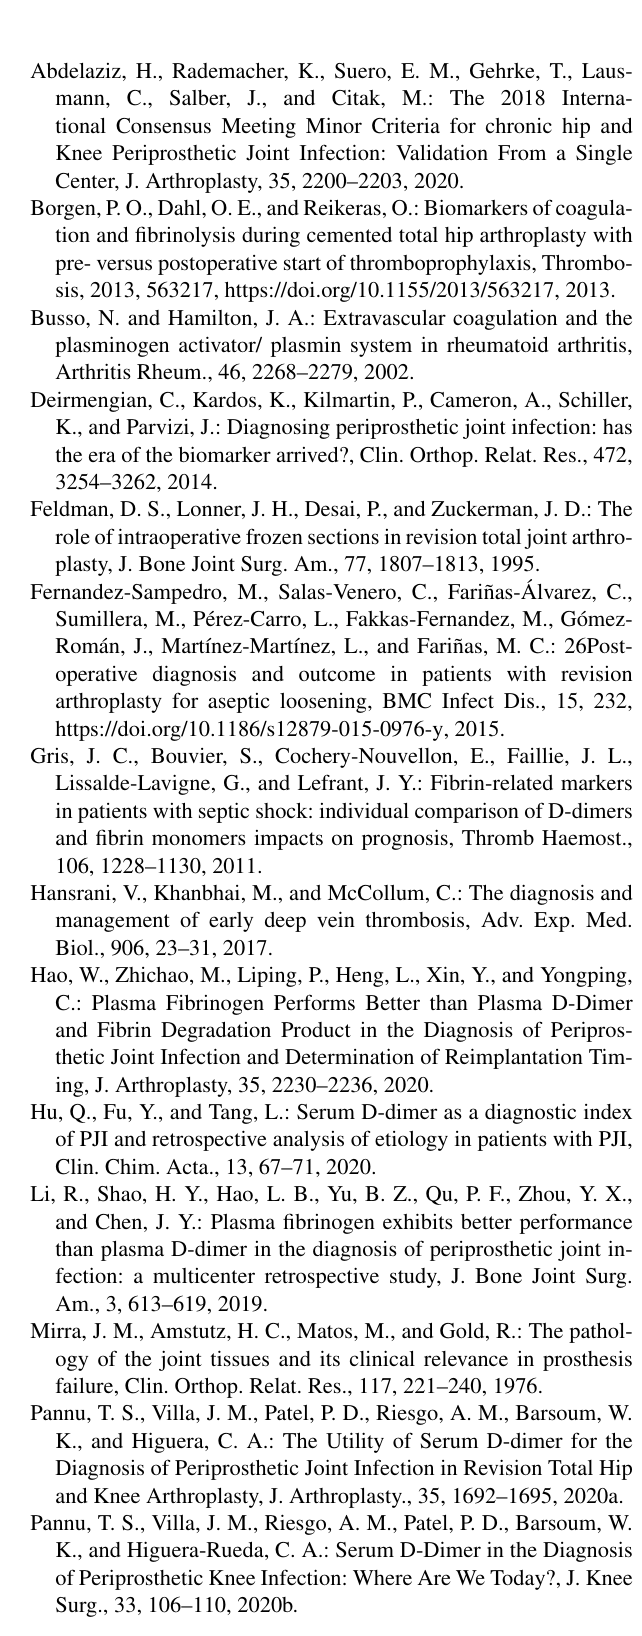
Table A2. Positive (PPV) and negative predictive value (NPV) of prosthetic joint infection for all cutoff points studied of D-dimer, C-reactive protein (CRP) and erythrocyte sedimentation rate (ESR) values. D-dimer ≥ 950mmh − 1 47.8% 95.7% ≥ 3000mmh − 1 62.5% 81.8% CRP ≥ 0.4mgdL − 1 50.0% 90.7%